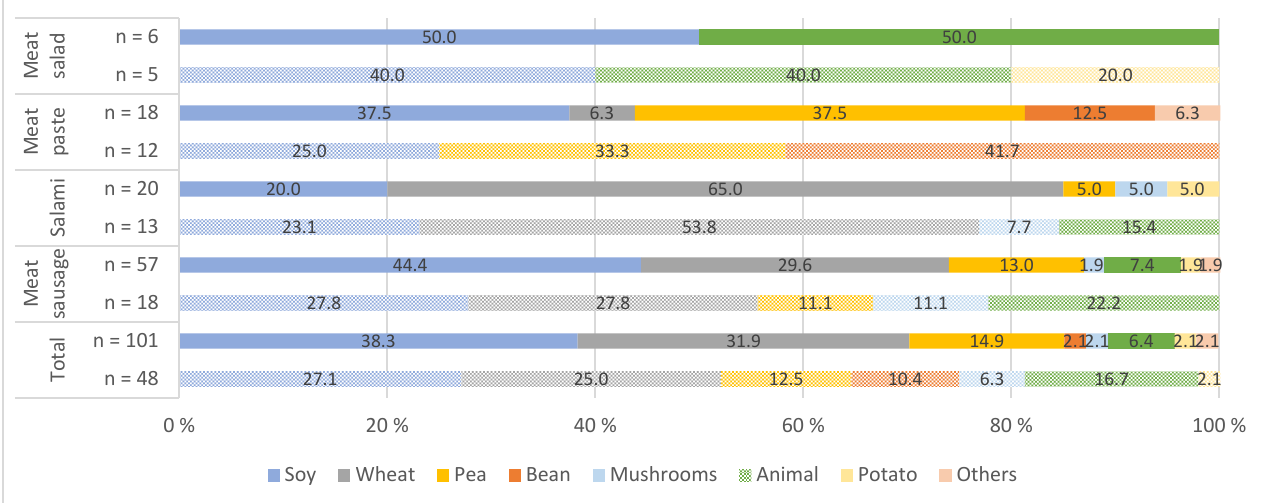
Figure 2. Protein sources used in plant-based meat alternatives (PBMA-cold) in 2019 (patterned color) and 2021 (solid color) (%); n = number of products; animal = milk and/or egg protein; others = millet, sunflower seeds.